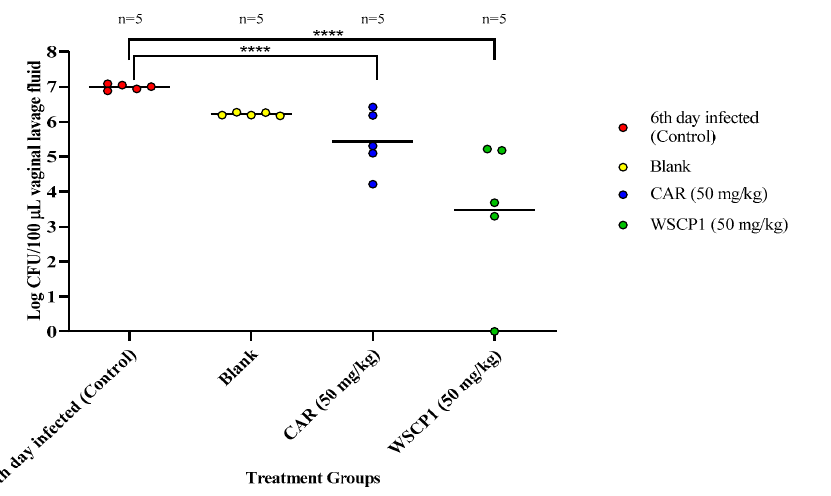
Figure 2. Effect of the CAR and the WSCP1 on VVC in a mouse model. **** p < 0.001 relative to control.